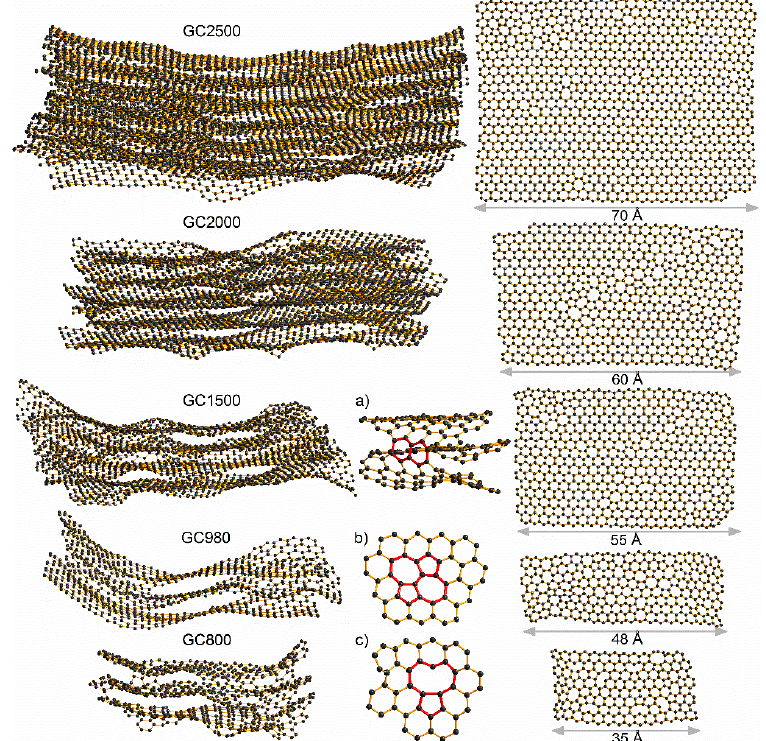
Figure 25. Models of averaged coherent scattering domains for polyfurfuryl alcohol-based glass-like carbons pyrolysed at temperatures: 2500, 2000, 1500, 980, and 800 °C (on the left) and the atomic configurations of single layers randomly separated from these models (on the right). ( a ) Fragment of the model with non-planar sp 2 bonding, ( b ) Stone–Thrower–Wales defect, and ( c ) monovacancy. Reproduced with permission from Jurkiewicz et al. [26]. Copyright International Union of Crystallography, 2017.